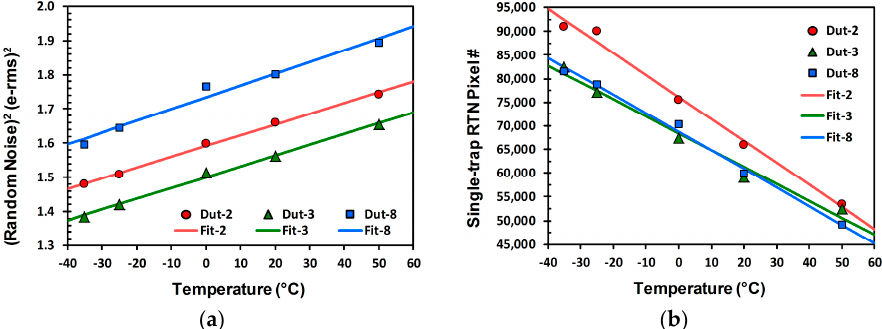
Figure 19. ( a ) The squares of the RN medians measured at the 8X gain are linearly dependent on the temperature, suggesting that they are dominated by the thermal noises; ( b ) The number of pixels with single RTN trap, i.e., the 2- and 3-peak pixels, increases as the temperature decreases. Because the longer time constants at lower temperature makes more pixels with RTN histogram peaks identifiable.